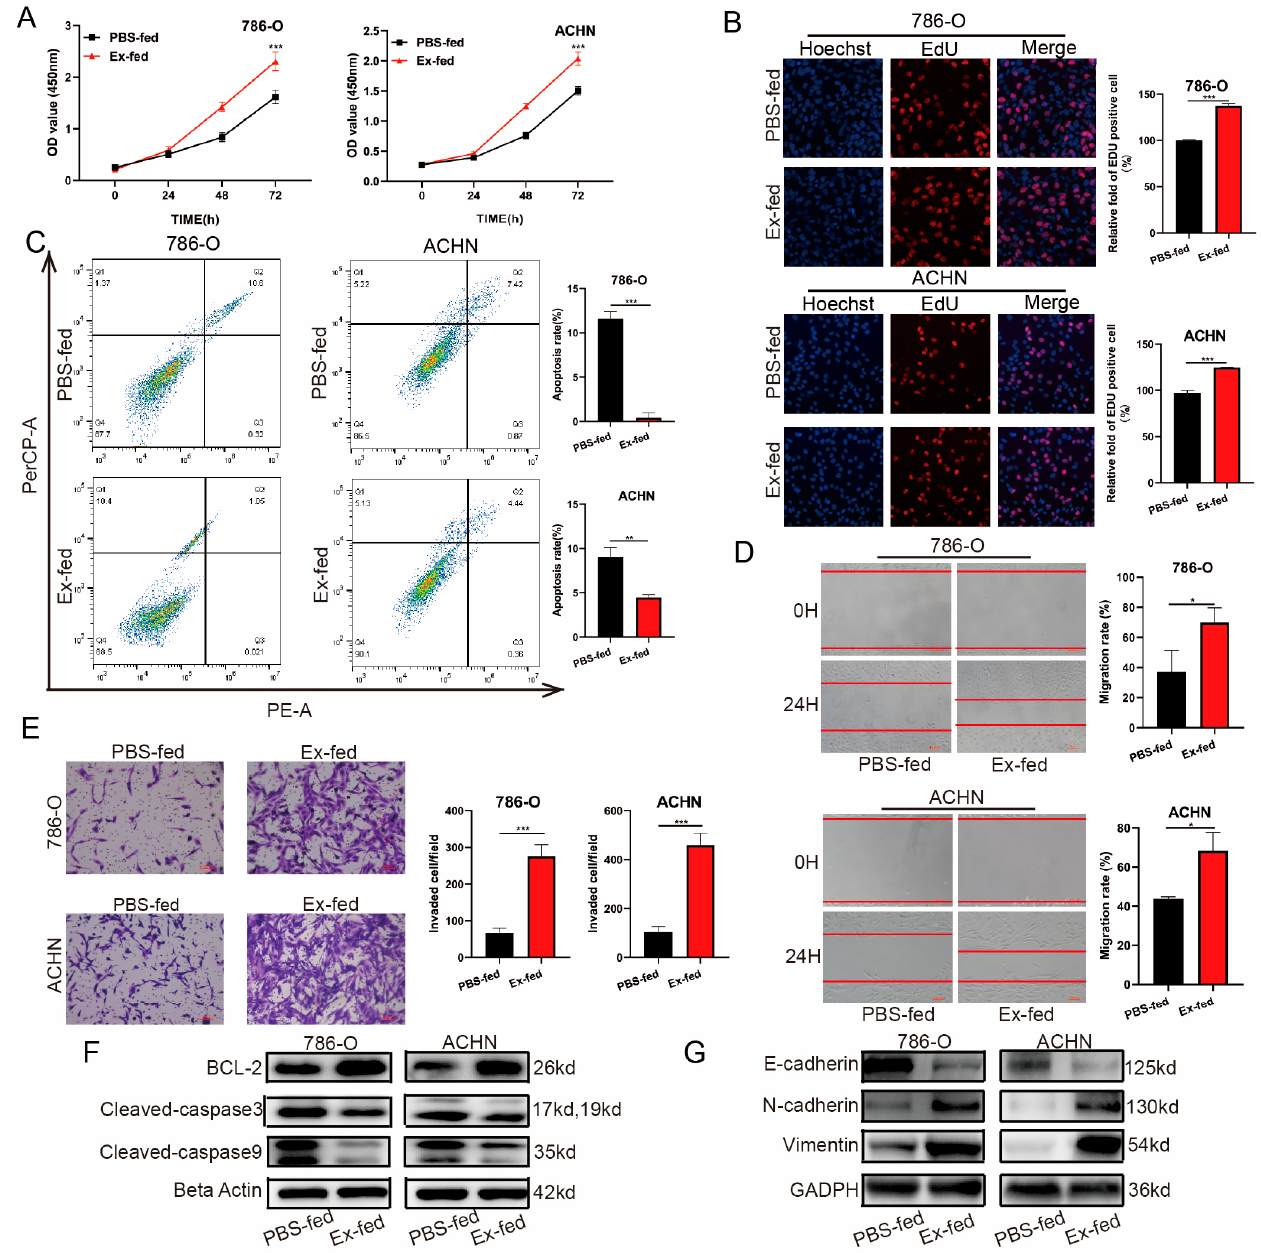
Figure 3. Caki-1-derived exosomes enhanced RCC proliferation, migration, invasion, and apoptosis inhibition. ( A , B ) Cell proliferation of 786-O and ACHN treated with PBS or Caki-1-derived exosomes was detected by a CCK8 and EdU assay. ( C ) Cell apoptosis was detected by flow cytometry analysis. ( D ) Cell scratch assay for migration ability of 786-O and ACHN transfected with PBS or Caki-1-derived exosomes. ( E ) Transwell assay for invasion ability of 786-O and ACHN transfected with PBS or Caki-1-derived exosomes. ( F ) Protein expression of representative apoptosis-related proteins in 786-O and ACHN treated with PBS or Caki-1-derived exosomes. ( G ) Protein expression of representative invasion-related proteins in 786-O and ACHN treated with PBS or Caki-1-derived exosomes. (* p < 0.05, ** p < 0.01, *** p < 0.001).